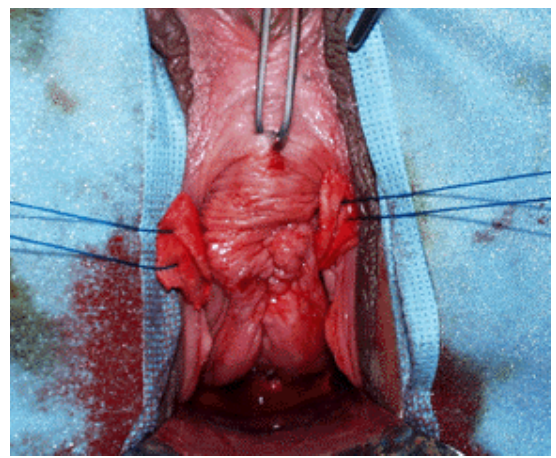
FIGURE 5 . Sling in place prior to tying sutures. Vaginal incisions are then closed with 2-0 polyglycolic acid sutures and an antibiotic soaked vaginal pack is